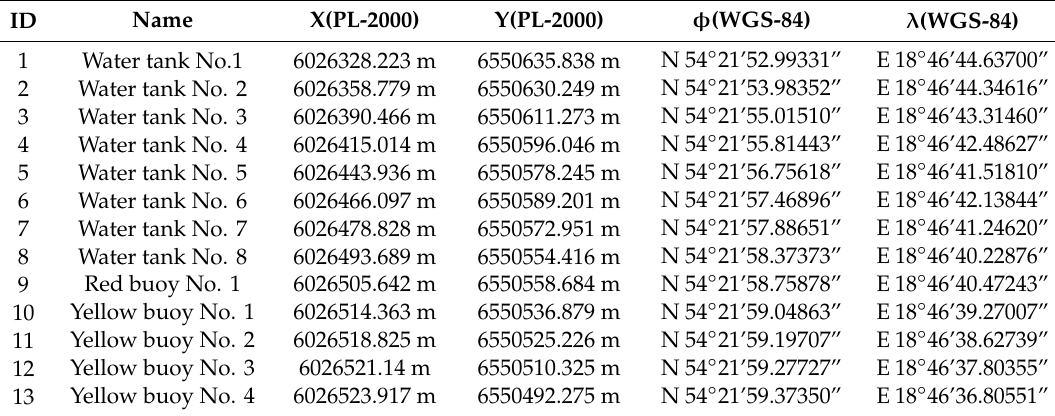
Table 1. The coordinates of the navigation marks indicating the Green Islands shoal, on the approach fairway to the yacht port complex of the National Sailing Centre (NSC) and Central Center for Academic Sport AZS Górki Zachodnie from the south.